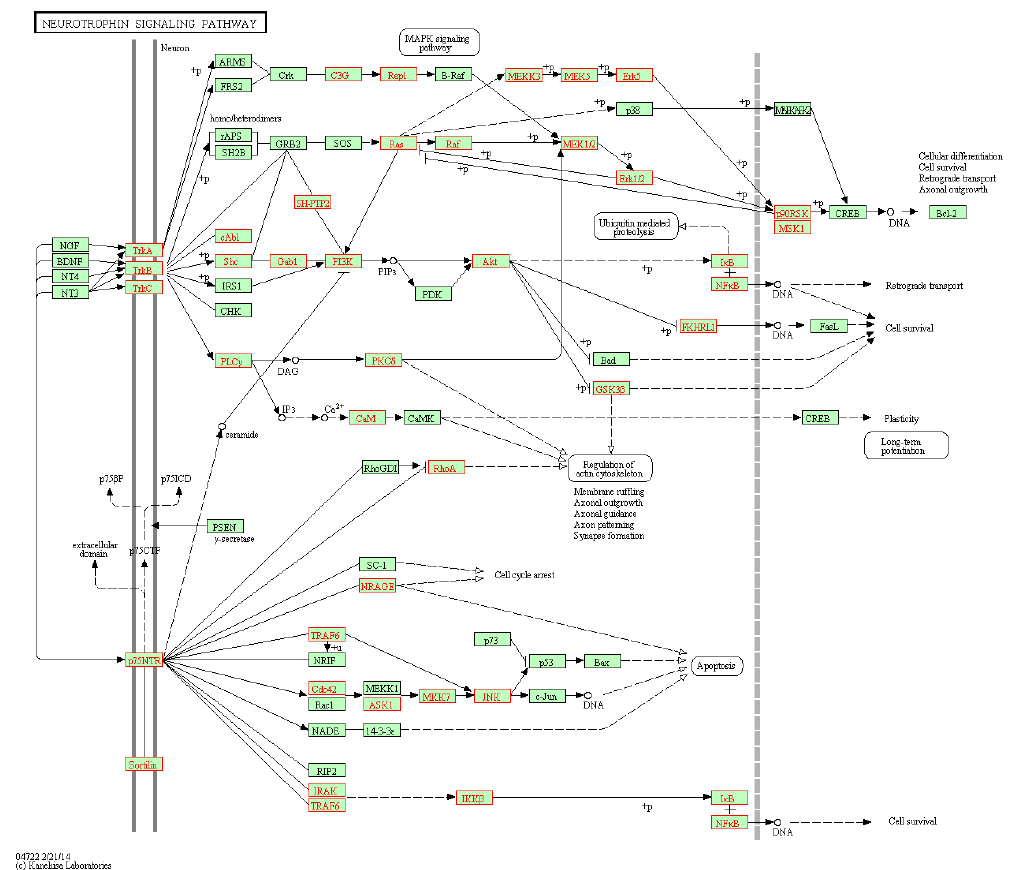
Figure 5. Neurotrophin signaling pathway and genes involved in the significant gene links (marked in red box).